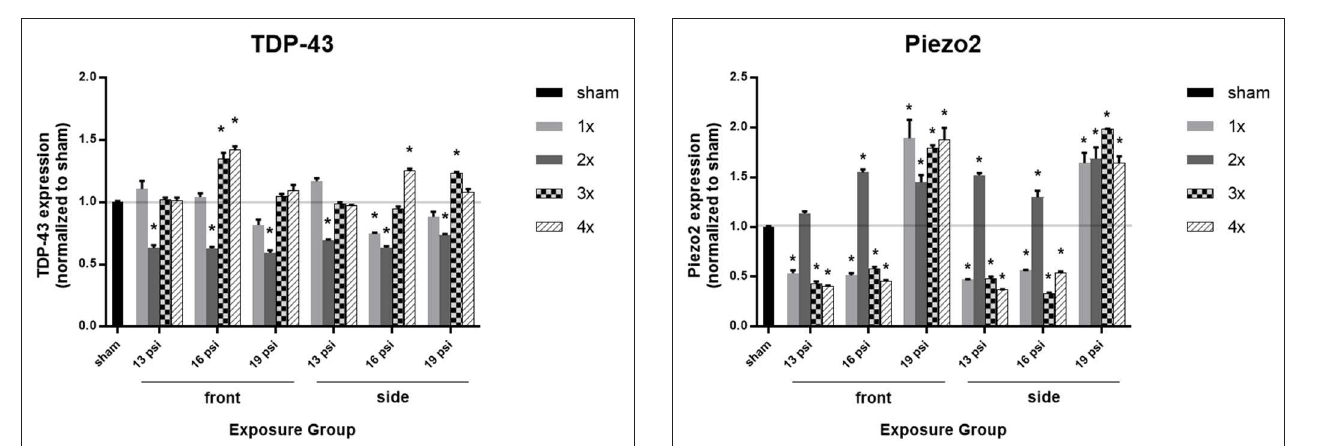
FIGURE 5 | Quantification of TDP-43 expression measured by Western blot. Results presented as blast intensity for each orientation (front vs. side). Values normalized to sham. Statistical significance compared to sham: * p < 0.05 (Significance values in Supplemental Table 4 ). Data is expressed as mean ± SEM, normalized to sham. Representative Westerns shown in Supplemental Figure 2 .